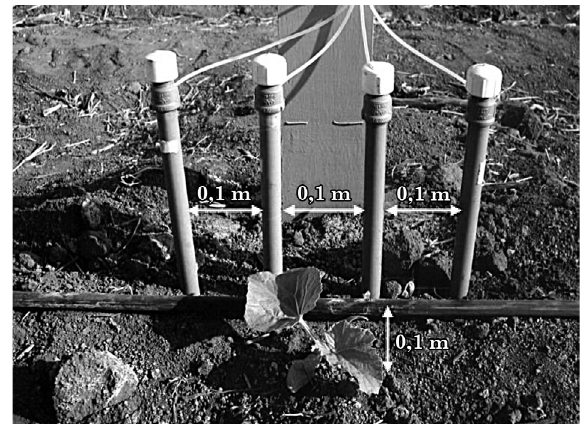
Figure 1. placement of tensiometers in relation to the plant and the irrigation